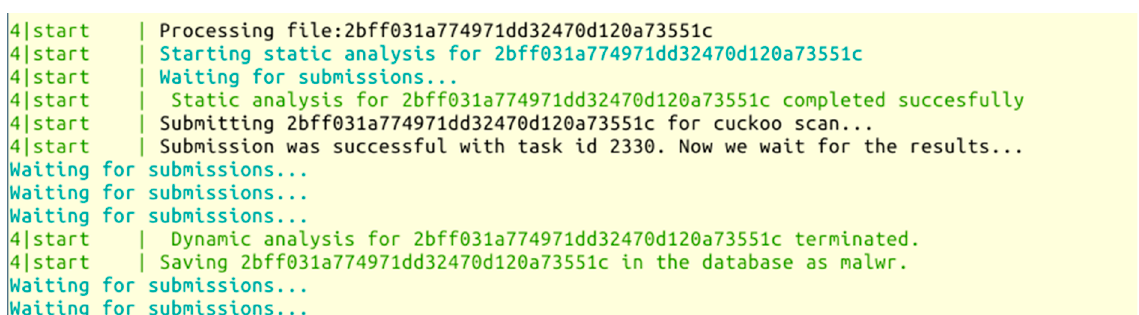
Figure 3. Sisyfos web interface.